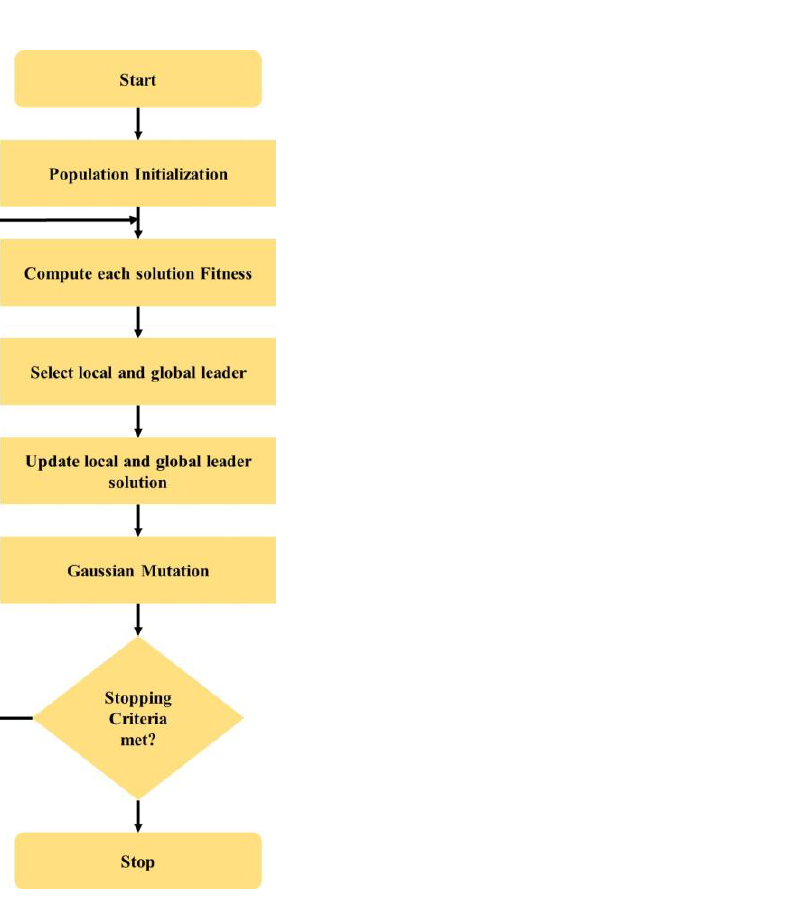
Figure 9. Gaussian Mutation – Spider Monkey Optimization for feature selection on scene classification. The SMO method step-by-step process is given